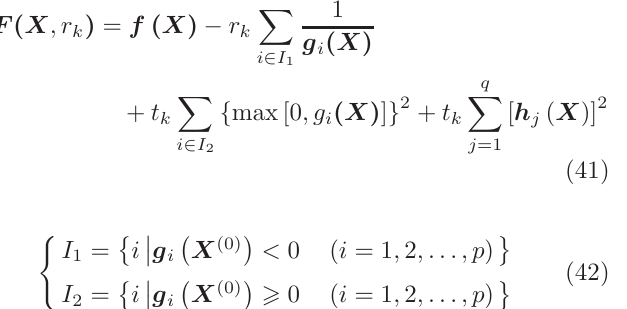
A SRC frame beam bears uniform load and its shear span ratio equals zero. The maximum internal force at beam end section is given as M A = − 500 kNm and V A = 250 KN; the maximum bending moment in the mid- dle section of the span equals 300 kNm. The